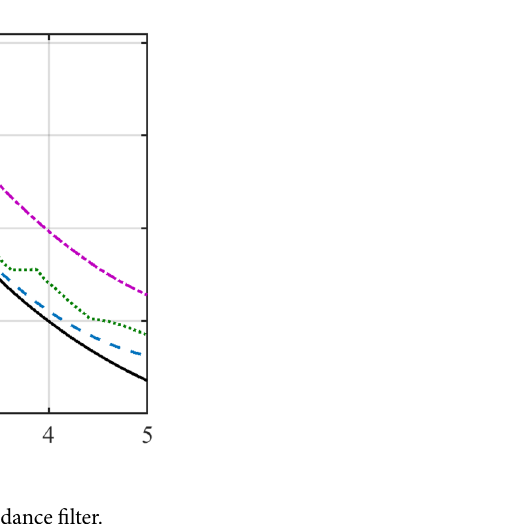
Figure 8. Magnitude of S 21 of the stepped-impedance